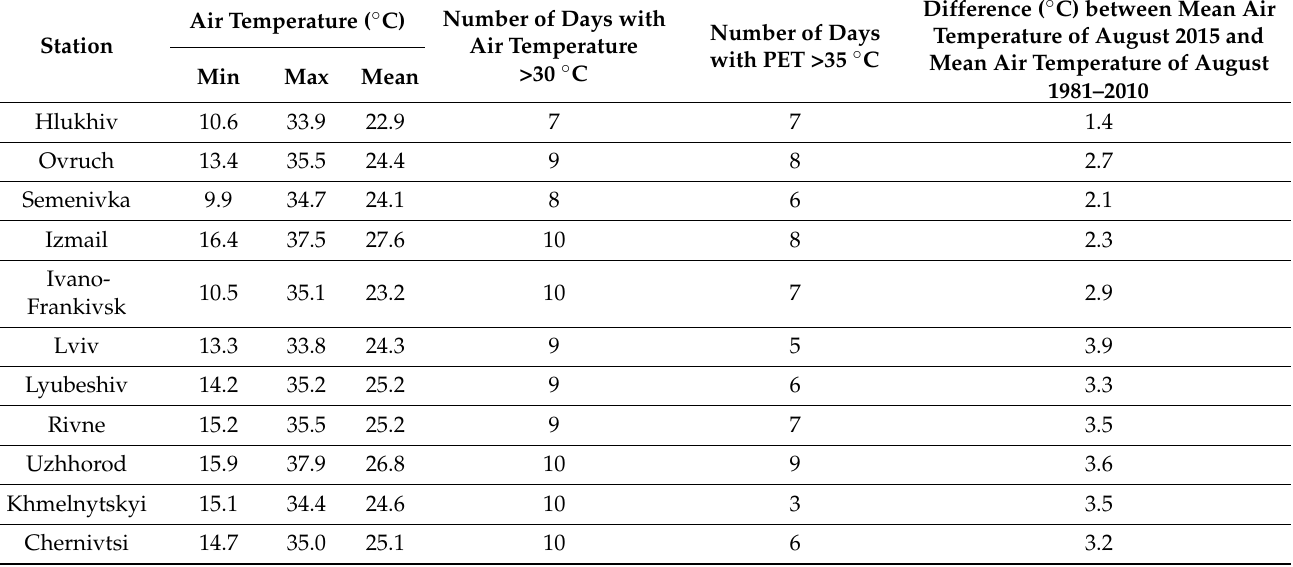
Table 5. Characteristics of air temperature regime and number of days with PET >35 ◦ C during mega-heat wave in 2015 (from 5 to 14